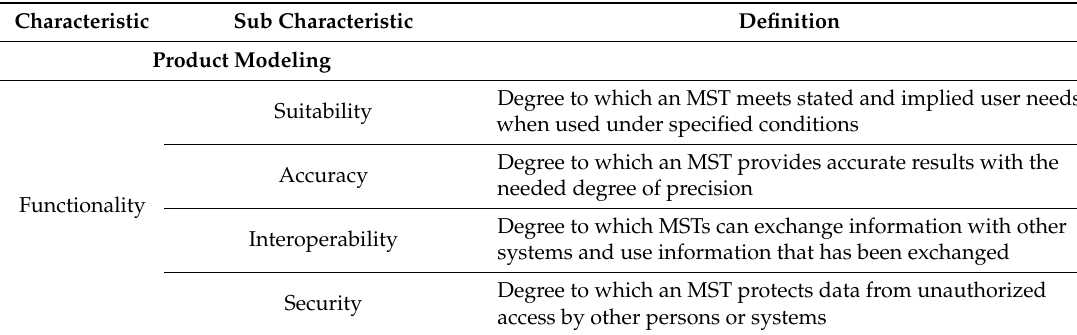
Table 1. Quality model for MSTs (Adapted from ISO/IEC 25010 and ISO